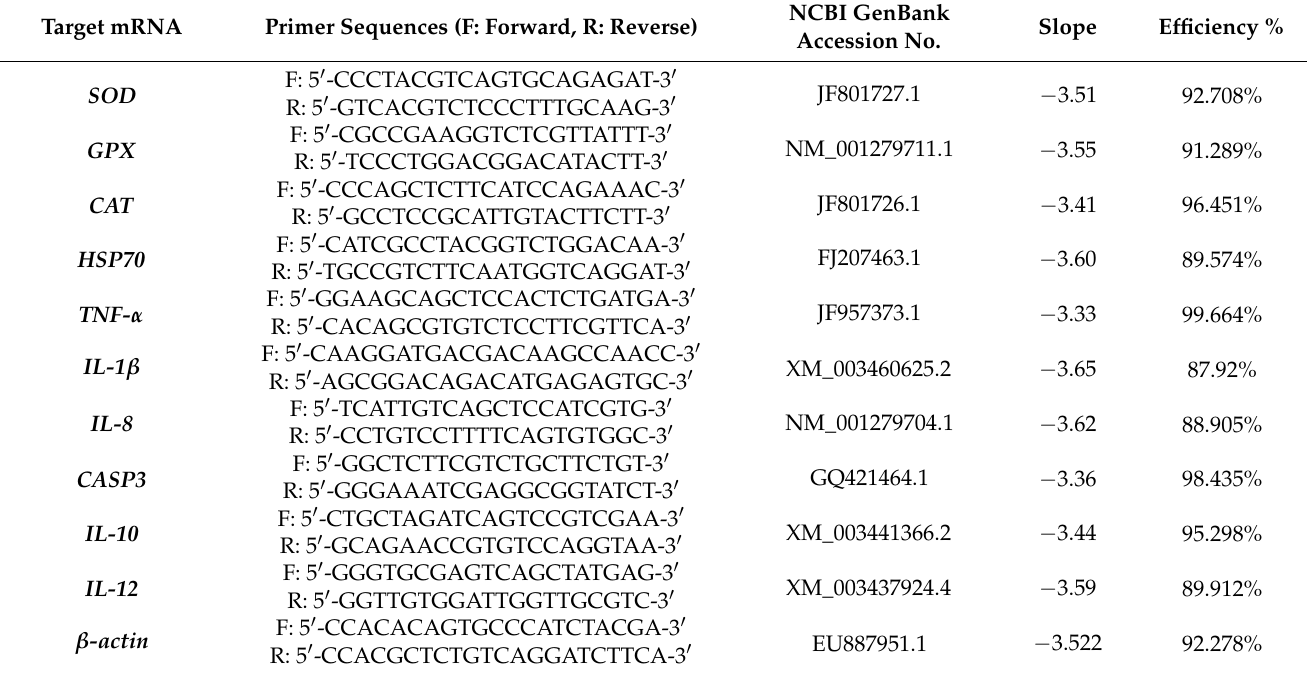
Table 1. Primer sequences, accession numbers, and primer efficiencies of the target mRNA used for the RT-PCR study. Target